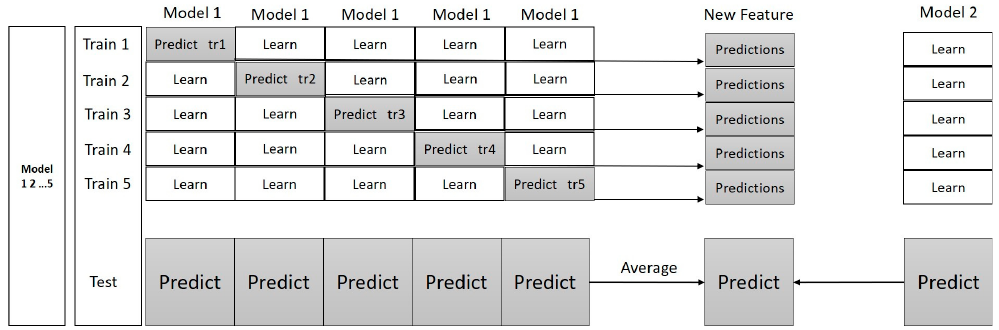
Figure 3. Training of the first layer base classifiers.